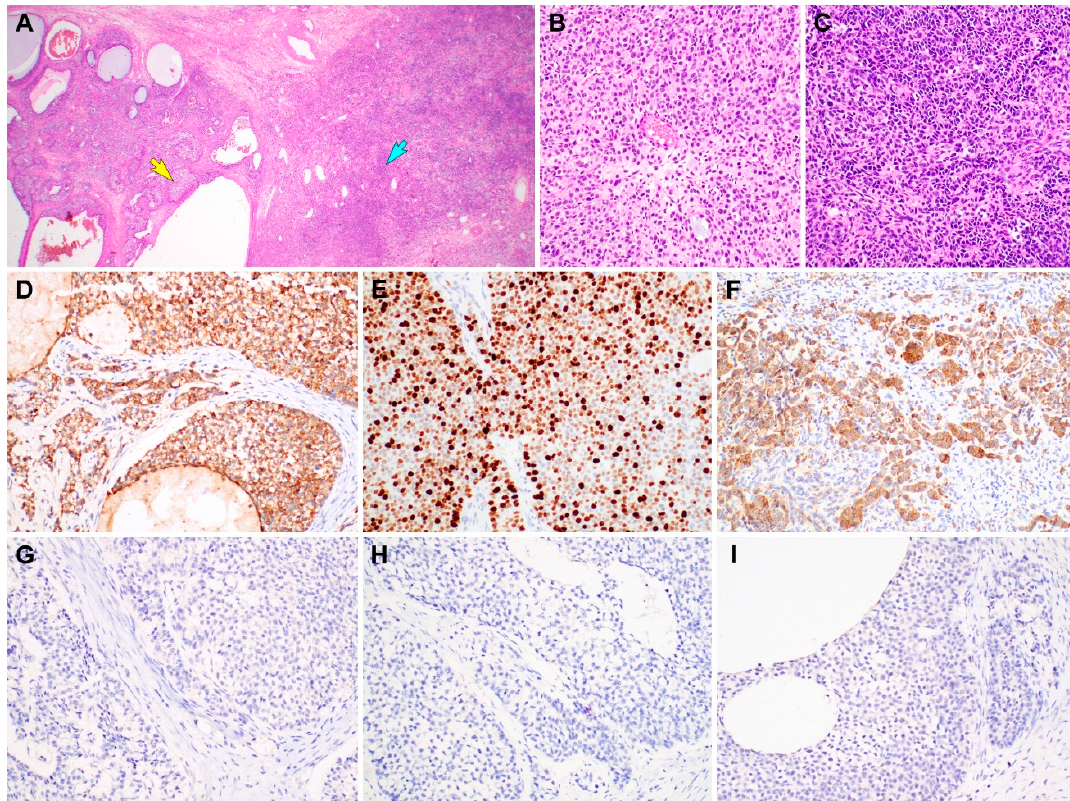
Figure 4. Immunostaining results of gynandroblastoma (GAB). ( A ) Both the juvenile granulosa cell tumor (JGCT; left half) and Sertoli-Leydig cell tumor (SLCT; right half) components are seen. ( B ) High-power magnification of the area indicated by a yellow arrow in image A reveals solid sheets of JGCT cells possessing an abundant eosinophilic cytoplasm. ( C ) High-power magnification of the area indicated by a blue arrow in image A reveals a diffuse proliferation of darkly stained Sertoli cells forming vague cords and nests. ( D ) Inhibin- α immunostaining uniformly highlights the JGCT cells. ( E ) The JGCT component exhibits high Ki-67 labeling index (approximately 70%). ( F ) The SLCT component also shows uniform cytoplasmic inhibin- α immunoreactivity. ( G – I ) In contrast, the JGCT and SLCT cells are negative for ( G ) epithelial membrane antigen, ( H ) pan-cytokeratin, and ( I ) paired box 8. Based on the morphological evidence of both the female and male components, lack of epithelial and Mullerian lineage markers, and inhibin- α immunoreactivity [2–8], the final histological diagnosis of ovarian GAB with a JGCT component was established. She did not receive any further treatment such as postoperative chemotherapy or radiation therapy. Two months after surgery, she is well without evidence of recurrent disease or distant metastasis. To the best of our knowledge, there has been only a single case of GAB with JGCT diagnosed in a postmenopausal woman [9–11]. This is the second case of GAB with JGCT in an elderly woman who had been in post-menopause for 15 years. The stains used were hematoxylin and eosin stain in A – C and polymer method in D – I . The original magnifications were 12.5 × in A and 200 × in B – I .